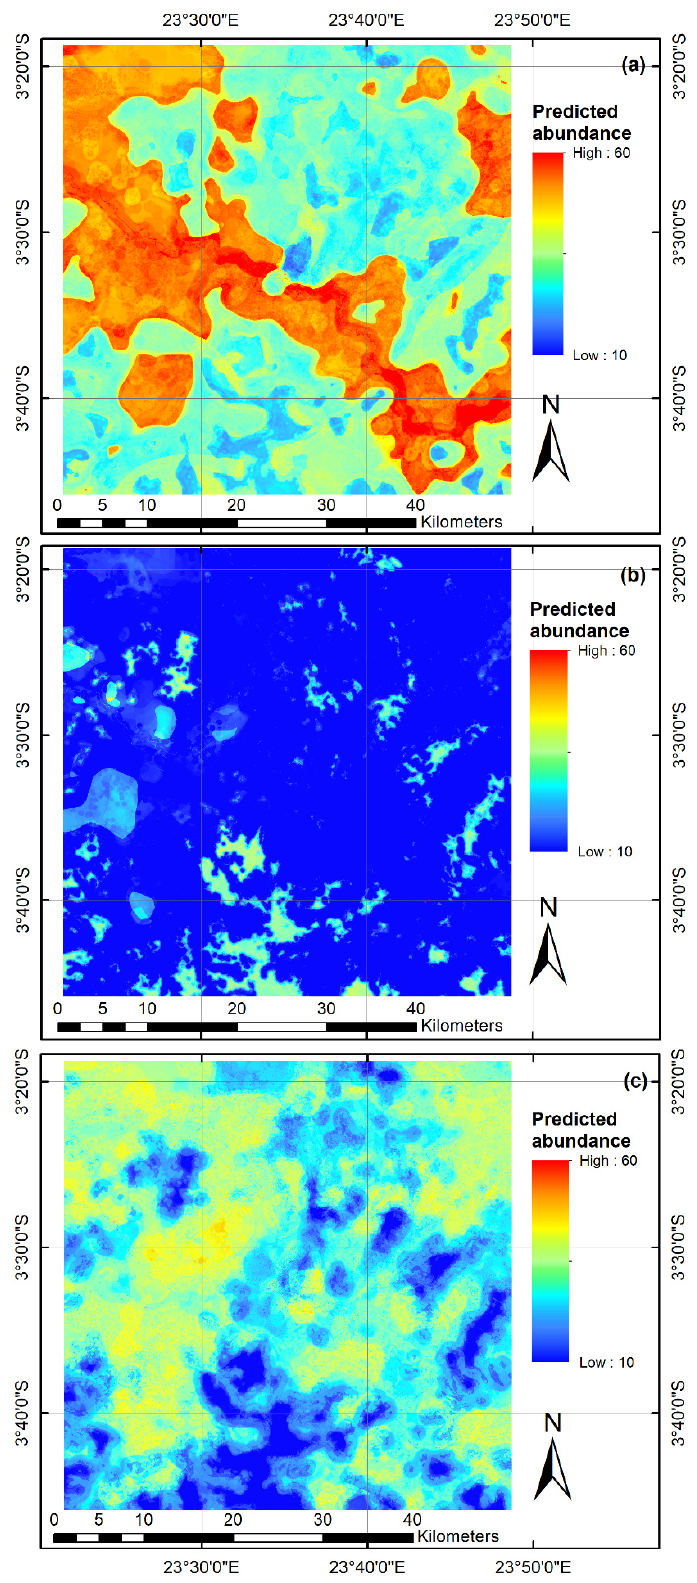
Figure 6. Predicted abundance of ( a ) An. gambiae s.l. ; ( b ) An. funestus ; and ( c ) An. paludis for the 50 km × 50 km Lodja study area extent for November 2015.